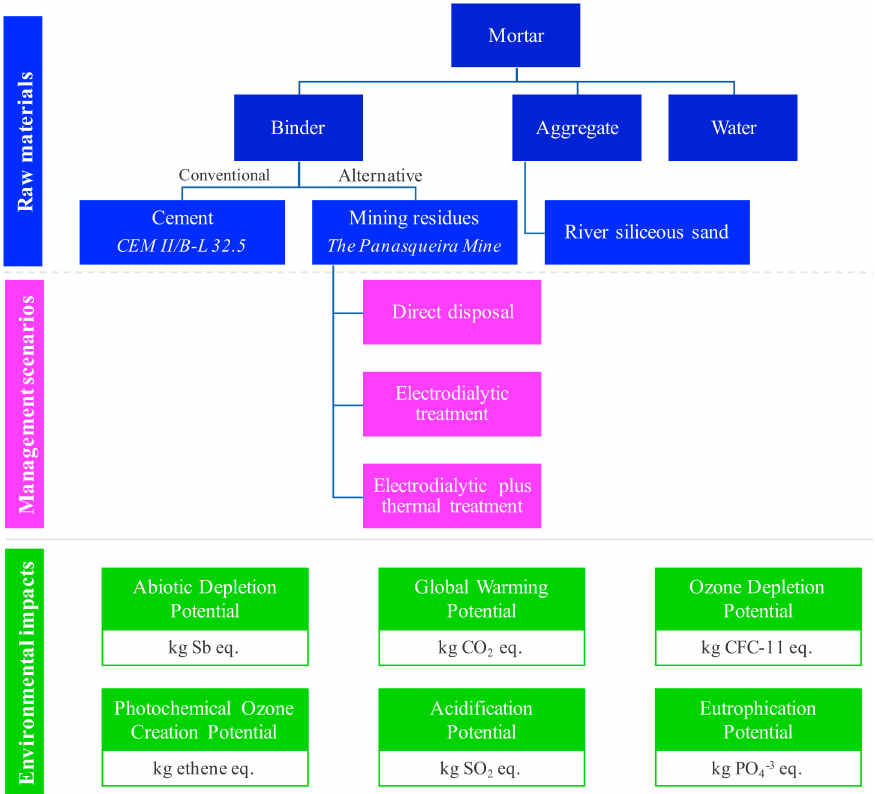
Figure 1. Flowchart of the elements included in the LCA of mortars, and the environmental impact categories